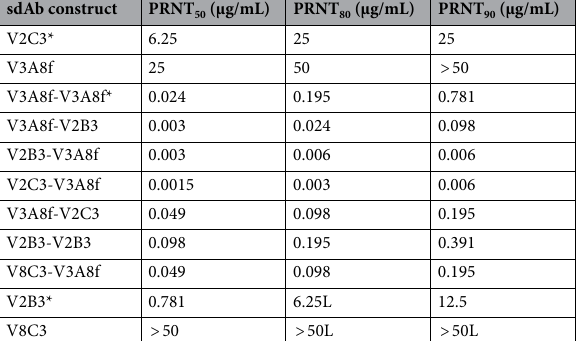
Table 5. Neutralization of VEEV-TrD. *plaque size increased as concentration of antibody decreased.